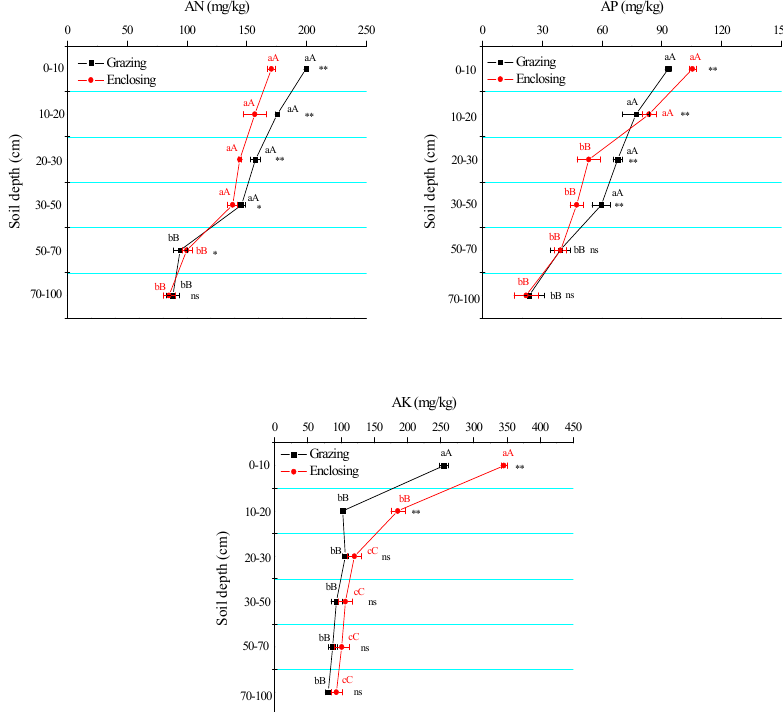
Figure 3. The effects of long term grazing and enclosing on contents of soil AN, AP and AK. Note: * and ** indicate significant differences at p < 0.05 level and p < 0.01 level of AN, AP and AK contents in each soil layer between the long term grazing plot and the long term enclosing plot and ns indicates no significant difference ( t test). Different lower case and capital letters indicate significant differences at p < 0.05 level and p < 0.01 level of AN, AP and AK contents among different soil layers for long term grazing or long term enclosing by one-way analysis of variance (ANOVA). Error bars were one standard deviation.